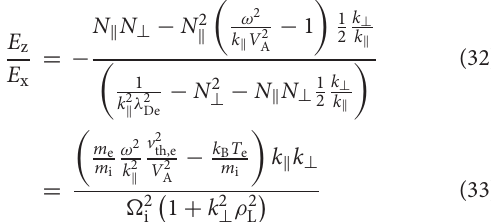
FIGURE 4 | Transport ratios for different values of ion beta. The parameter set is taken from Figure 2